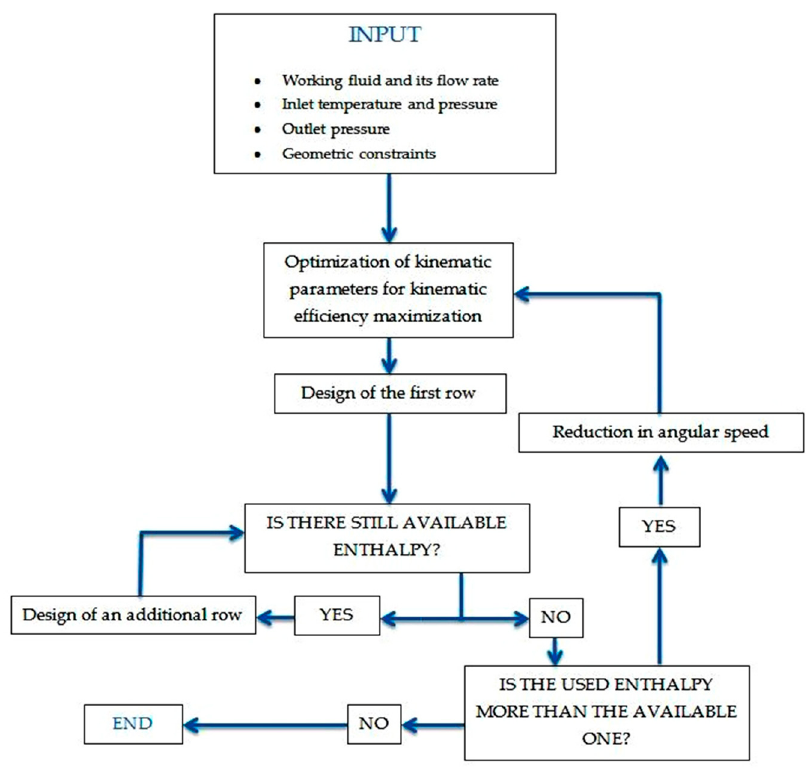
9 of 16 Table 7. Inputs and constraints of the algorithm. (cid:1865)(cid:4662)